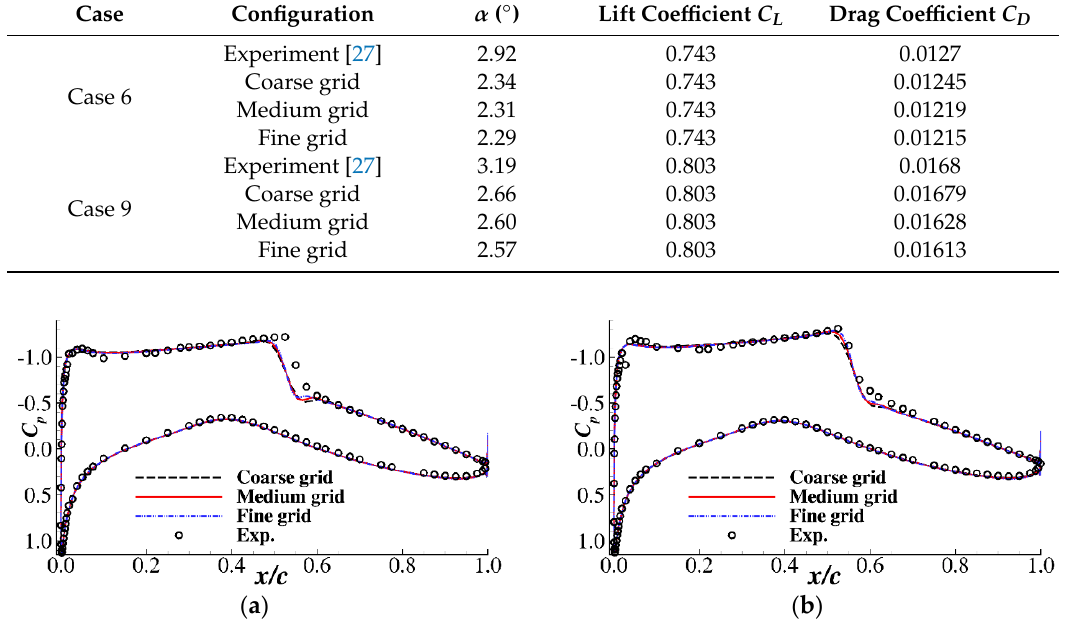
Figure 2. Pressure coefficient comparisons for the RAE2822 airfoil. ( a ) Case 6: Ma = 0.725, Re = 6.5 × 10 6 , CL = 0.743; ( b ) Case 9: Ma = 0.730, Re = 6.5 × 10 6 , CL = 0.803.